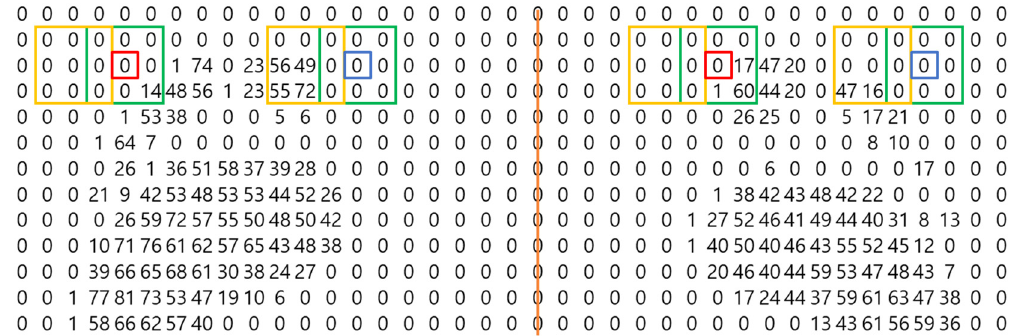
Figure 11. Locating the start and end points of the foot.